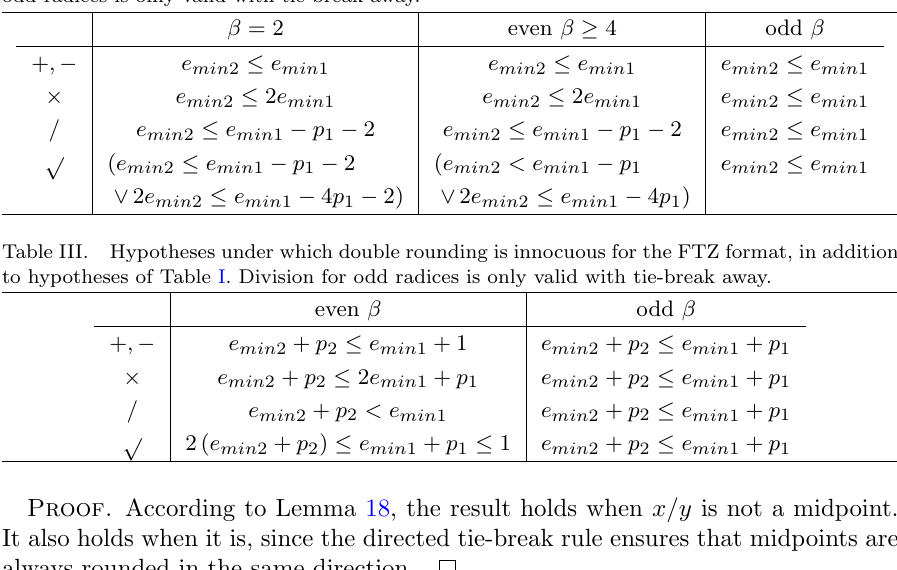
Table II. Hypotheses under which double rounding is innocuous for the FLT format, in addition to hypotheses of Table I ( e min 1 and e min 2 are the two minimal exponents involved). Division for odd radices is only valid with tie-break away.